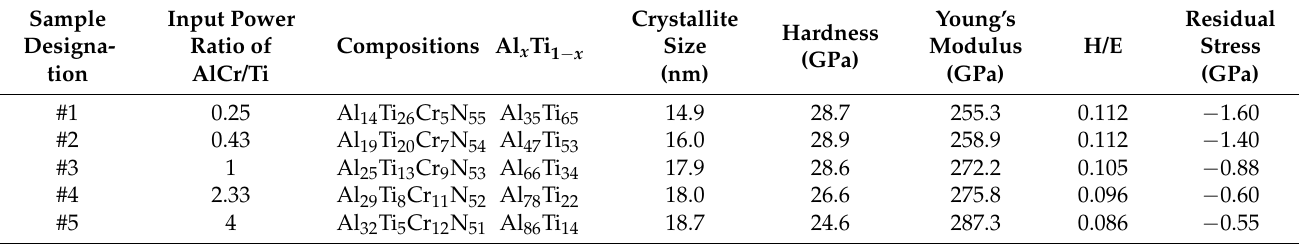
Figure 6. XRD patterns obtained from the AlTiCrN coatings deposited using various AlCr:Ti input power ratios. Table 3. The mechanical properties and chemical composition of the AlTiCrN coatings deposited under various AlCr:Ti input power